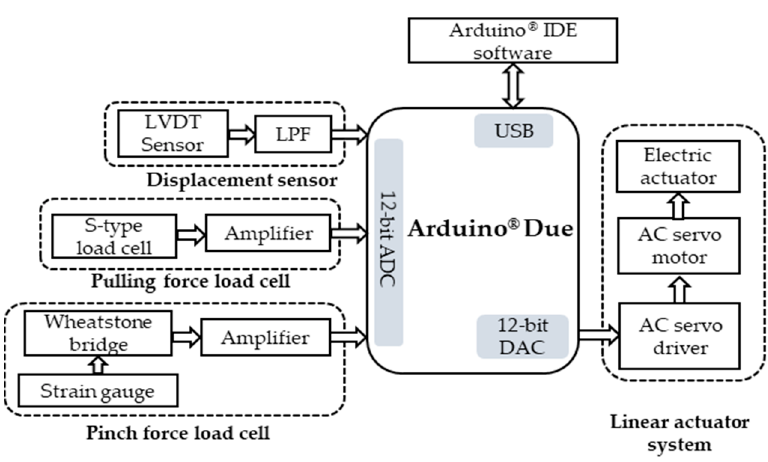
Figure 8. Displacement-voltage relationships of three times calibration. .